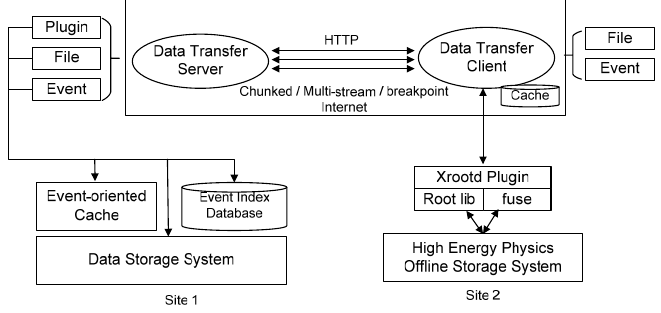
Fig. 5. The architecture of event-oriented data transfer service.